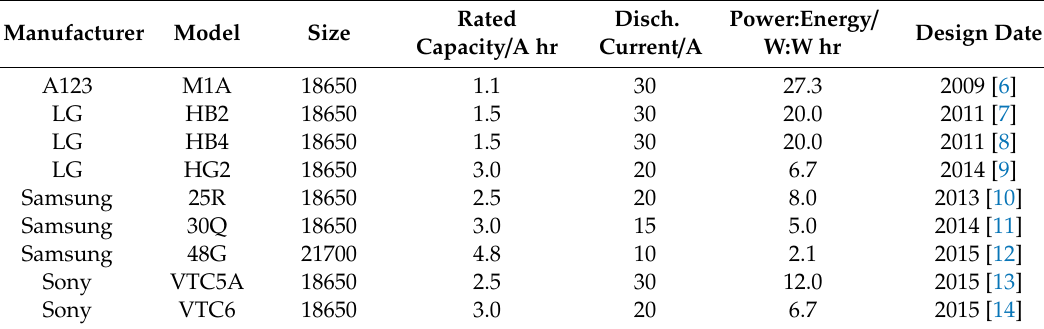
Table 2. Lithium ion cells included in this